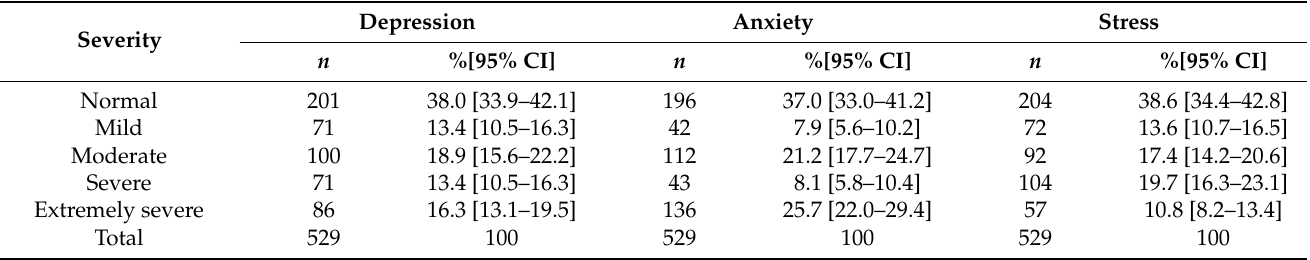
Table 3. Prevalence (point and 95% confidence interval) of the depression, anxiety and stress symp- toms in the